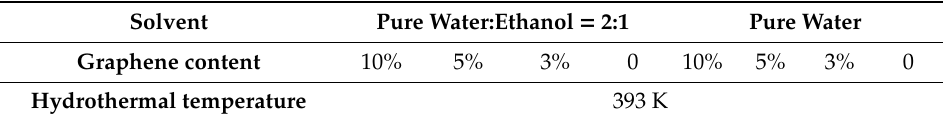
Table 3. The graphene content and solvent of other catalysts. Solvent Pure Water:Ethanol =